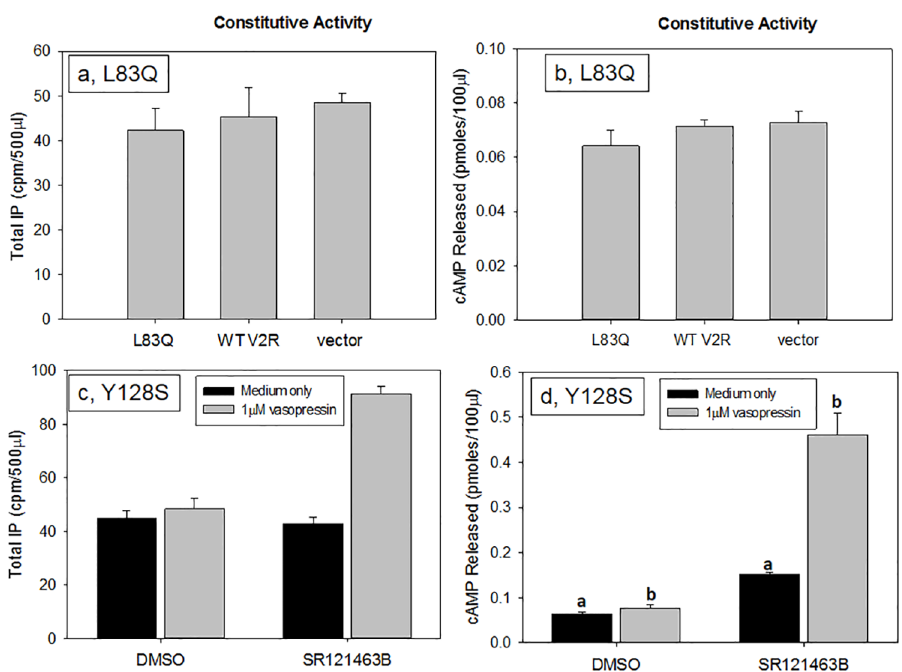
Fig 9. Constitutive or stimulated activity of V2R mutants with or without rescue. Transientlytransfected HeLa cells containinga total of 100ng cDNA / 0.125 ml of hWT V2R, L83Q mutant and empty vector were used to assess if there is constitutive activity (CA) with the IP pathway, 9a, or with the cAMP pathway, 9b. Figure 9c shows that Y128S, is coupledto Gq/11 in the presence of agonist (1 μ M vasopressin for 2 hours), but does not show constitutive activity (no agonist). Figure 9d shows constitutive activity of Y128S for the cAMP pathway. Cells were stimulatedfor 30 minutes with 1 μ M vasopressin. The results shown in the figure are from at least 3 independent experiments performed in quadruplicate (n = 3 ± SEM), p values < 0.05 is considered significant.